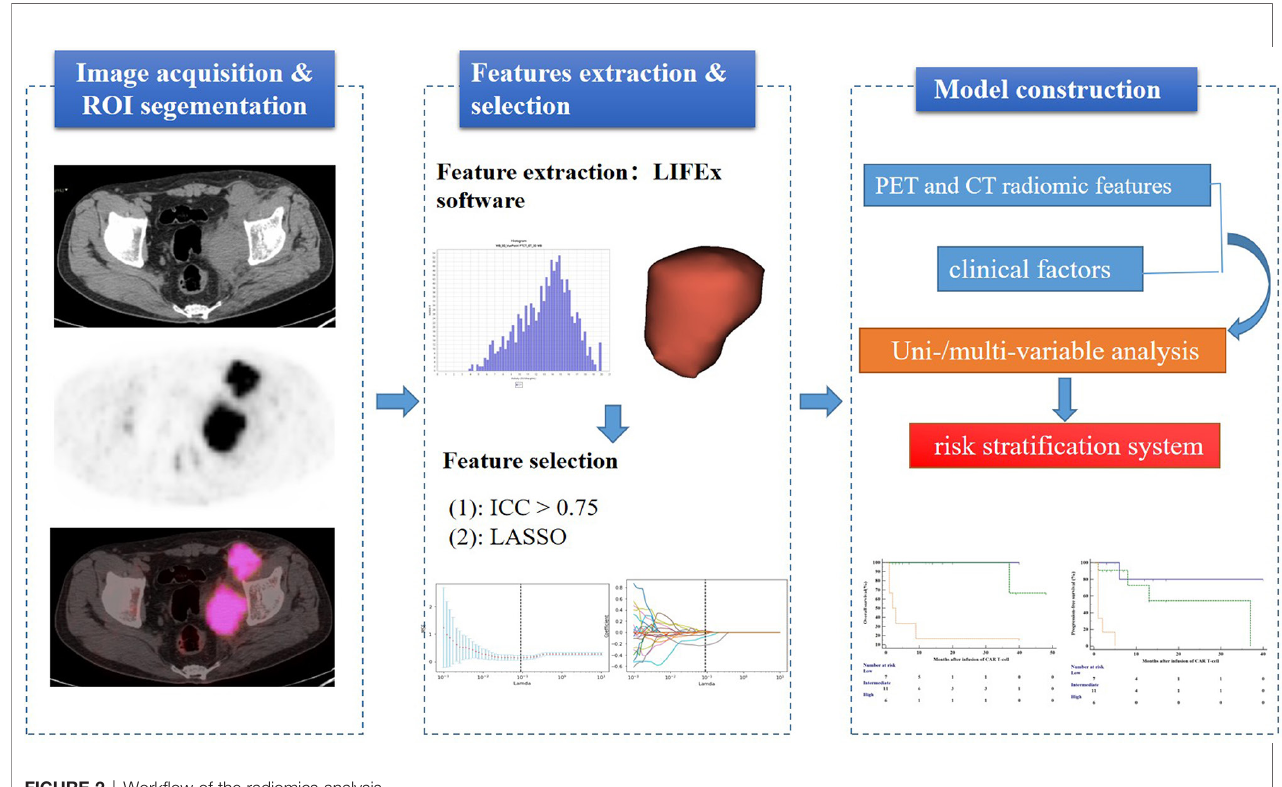
FIGURE 2 | Work fl ow of the radiomics analysis.